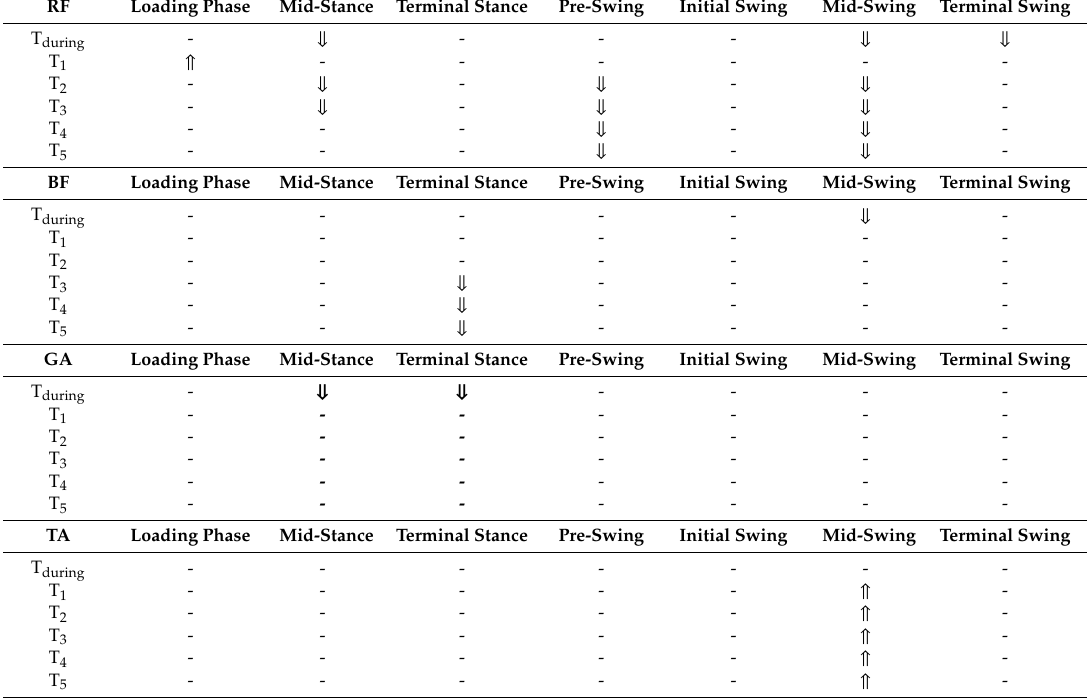
Figure 10. Group means ( ± SEM) of tibialis anterior (TA) muscle activity during the mid-swing phase of the gait cycle during control and unloading conditions across di ff erent epochs. * Significant di ff erence ( p < 0.05) relative to T 0 of the corresponding condition. Table 1. A summary of changes in EMG activity of all four muscles across di ff erent epochs and gait phases: The upward arrow indicates a significant ( p < 0.05) increase, and the downward arrow indicates a significant ( p < 0.05) decrease in activity relative to T 0 , while “-“ indicates no significant changes relative to T 0.